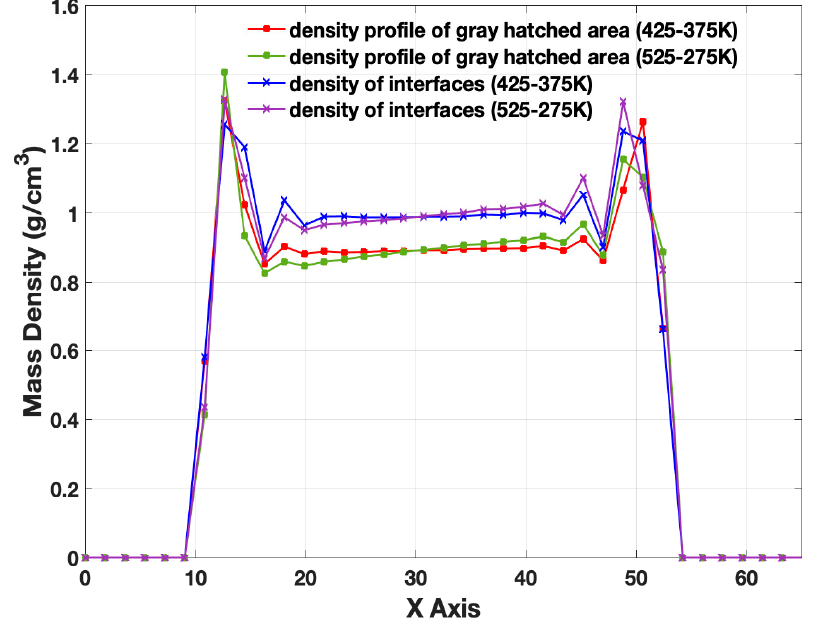
Figure 7. Mass density profiles of water along the X direction when only the temperature gradient is varied (see Figure 1) for cases A1 and A5 (see Table 1 for conditions). The red and green lines represent the regions shown as the bulk phase (grey hatched areas) and the adjoining interface regions (green hatched areas) shown in Figure 1. The blue and purple lines, respectively, show the interface regions (red hatched areas) and the adjoining “double” interface regions (unhatched white) shown in Figure 1.